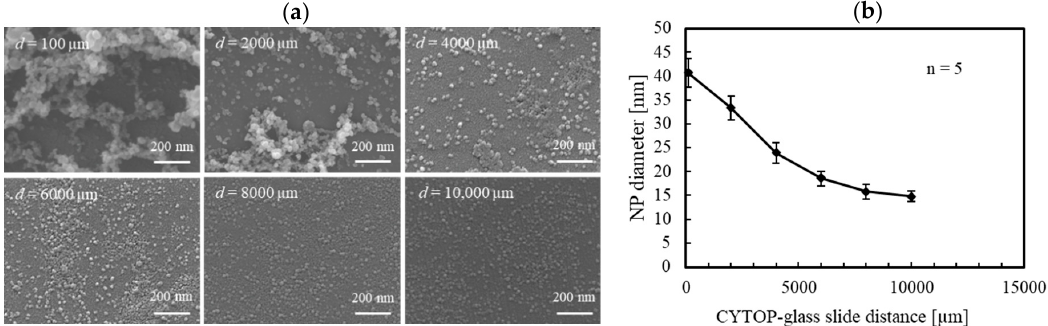
Figure 3. ( a ) SEM images of deposited NPs with different CYTOP-glass slide distances. ( b ) NP size as a function of the CYTOP-glass slide distance.